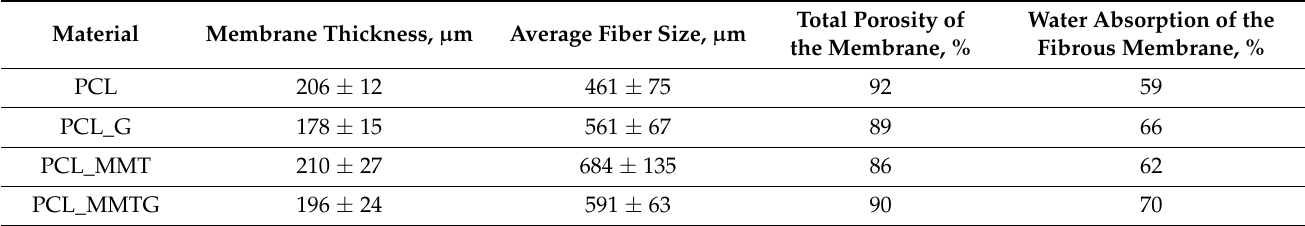
Table 3. Characteristics of fibrous membrane